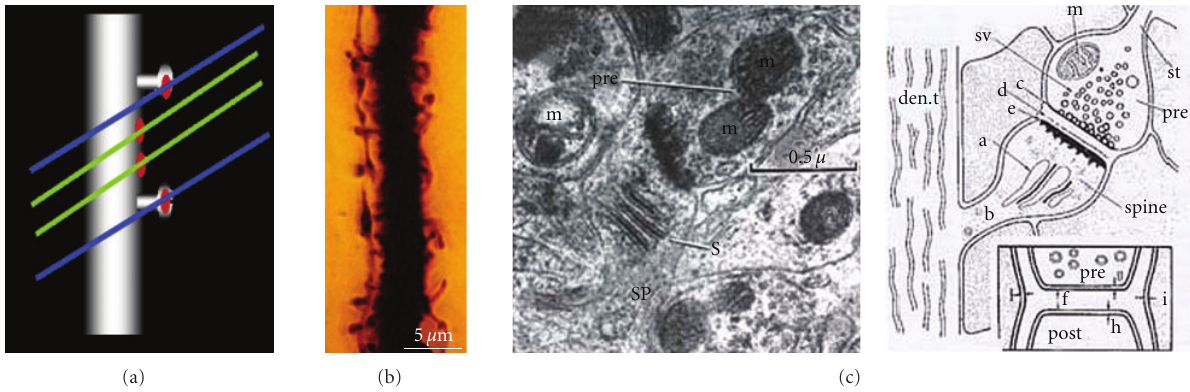
Figure 2: (a) 3D-model showing the physiological interpretation of the dendritic spines by Cajal that evolved from a role in canalizing the nervous fibers for contacting the dendrite (see [3], in green) to a connective function (see [4–7]; in blue). (b) Dendritic spines of an apical pyramidal trunk supposedly contacting an axon, Cajal histological preparation, Golgi impregnation. (c) Electron microscopy and scheme of dendritic spines as postsynaptic elements, gray